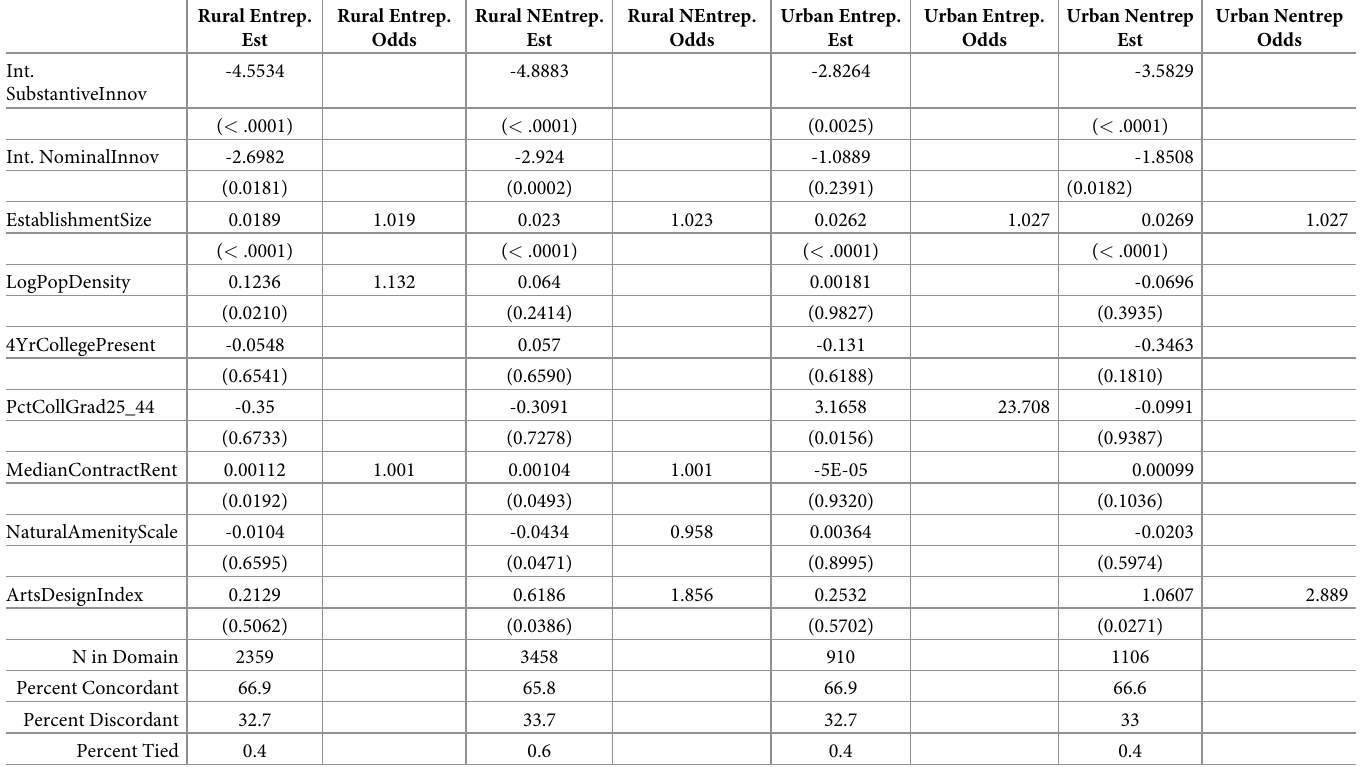
Table 5. Ordered logistic regression of innovation orientation for domains defined by entrepreneurial/non-entrepreneurial establishments and rural/urban status. Rural Entrep.